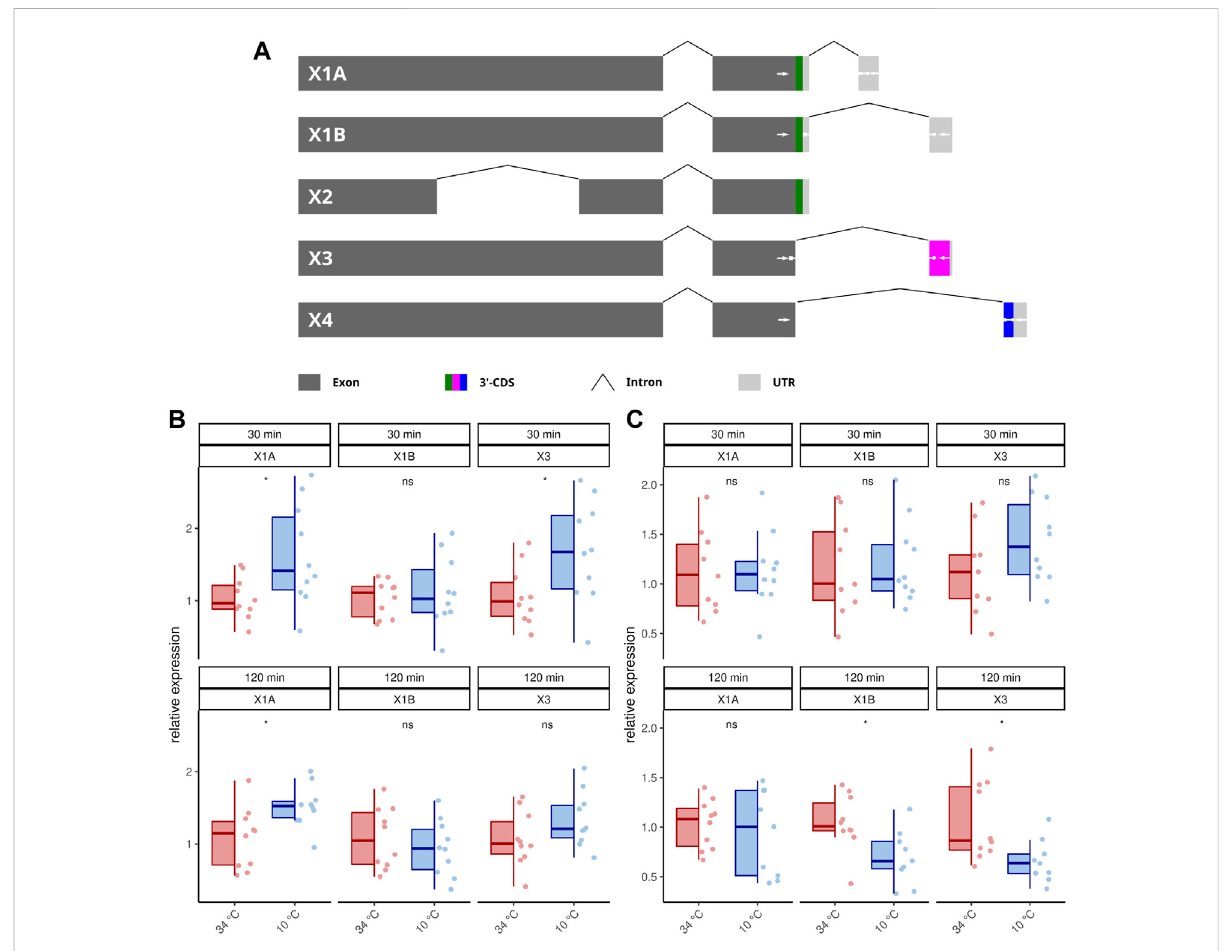
FIGURE 3 Differential splicing of AmOAR β 2 . (A) Schematic representation of AmOAR β 2 alternative splicing. Rectangles in dark gray represent the exons andtheintronsarevisualizedbychevronshapes.Inmulticolorthe3 ′ -codingsequence(3 ′ -CDS,includingthestopcodon)isshownofeachisoform. Theuntranslatedregion(UTR)isillustratedinlightgray. Whitearrows demarksequenceswhichgetspeci fi callytargeted bythedesignedprimersand probes(seealsoTable1). (B – C) Quanti fi cationofthe AmOAR β 2 isoformabundancein1 weekoldworkerbees (B) andforagerbees (C) .Foreach group/data-set median ± IQR (left part) and individual data points (right part) are shown. * = p < 0.05, ns = p ≥ 0.05, Mann-Whitney U test. For detailed statistics please see Table